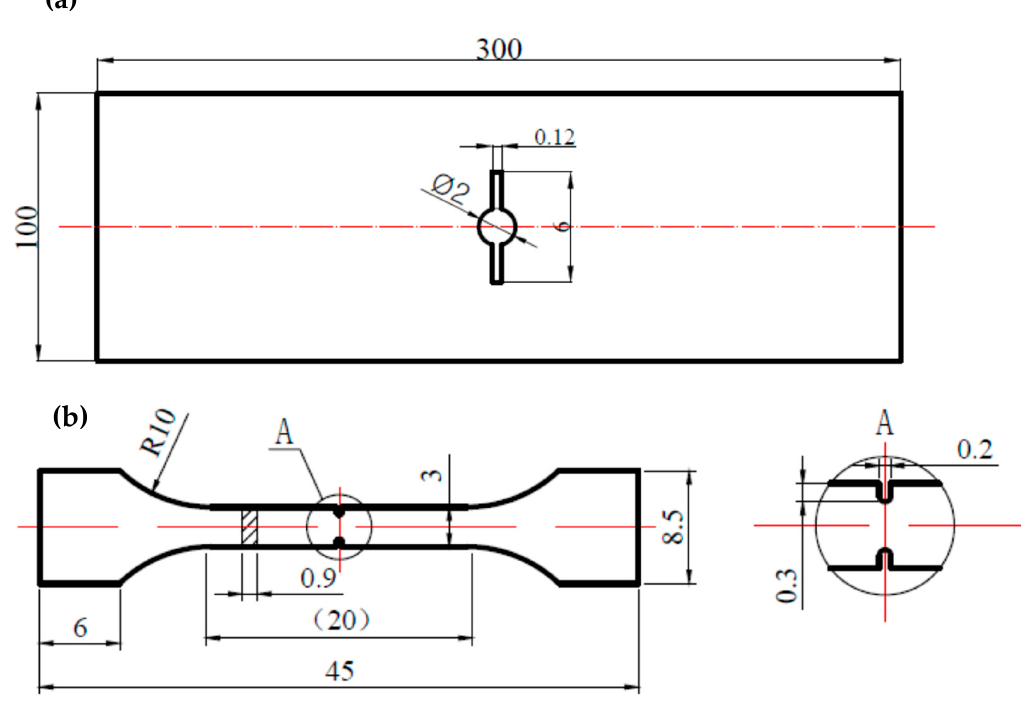
Figure 1. ( a ) The M(T) fatigue crack propagation test sample. M(T) specimen, transverse–longitudinal (T–L) orientation, W = 100 mm, 2 a 0 = 6 mm. ( b ) In-situ SEM fatigue specimen (all dimensions in mm).